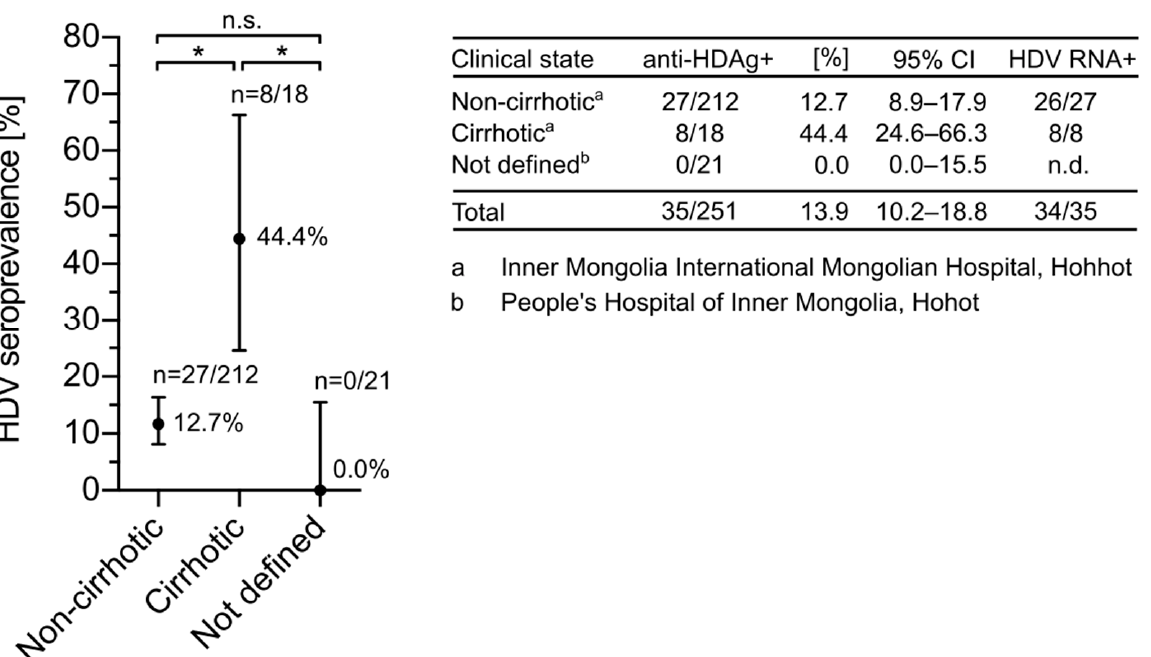
Figure 2. Distribution of HDV seroprevalence in Chinese patients at different stages of liver disease. Serum samples were collected from HBsAg-positive patients living in Inner Mongolia. The stage of liver disease was determined using standard diagnostic criteria. All sera were tested for anti-HDV-Ab using the HDV rapid test. CIs of 95%were calculated according to the Wilson score interval and seroprevalences were compared using the Chi-squared test. * corresponds to a p -value < 0.05.